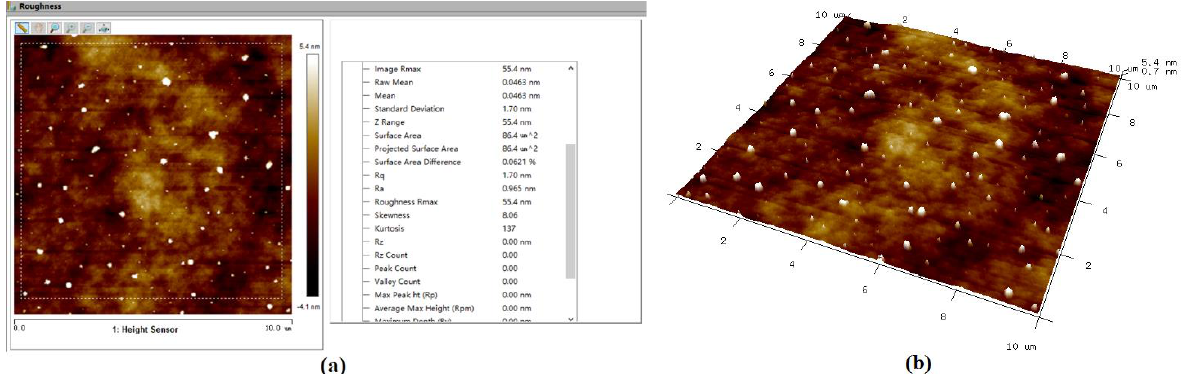
Figure 15. The original Si workpiece surface. ( a ) Surface roughness and ( b ) surface morphology.